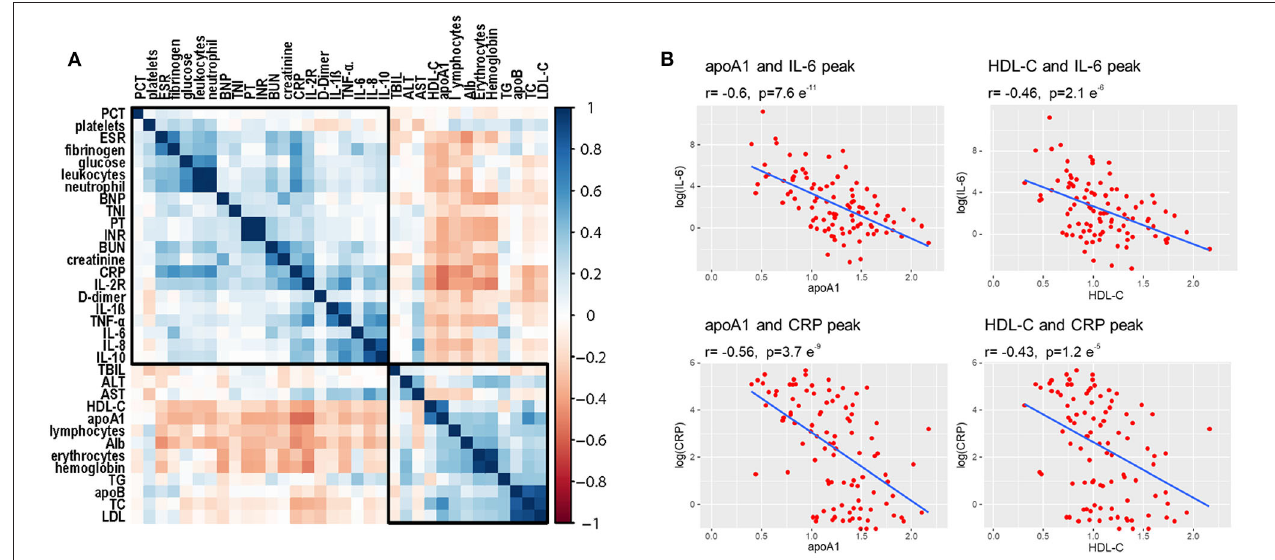
FIGURE 5 | Correlations among lipid profiles and laboratory parameters. (A) Heatmap values represent pairwise Spearman rank correlation coefficients. Blue indicates positive correlation, red indicates negative correlation. (B) Spearman correlation coefficient analysis shows that initial HDL-C and apoA-1 levels were significantly inversely correlated with peak values of CRP and IL-6 during disease